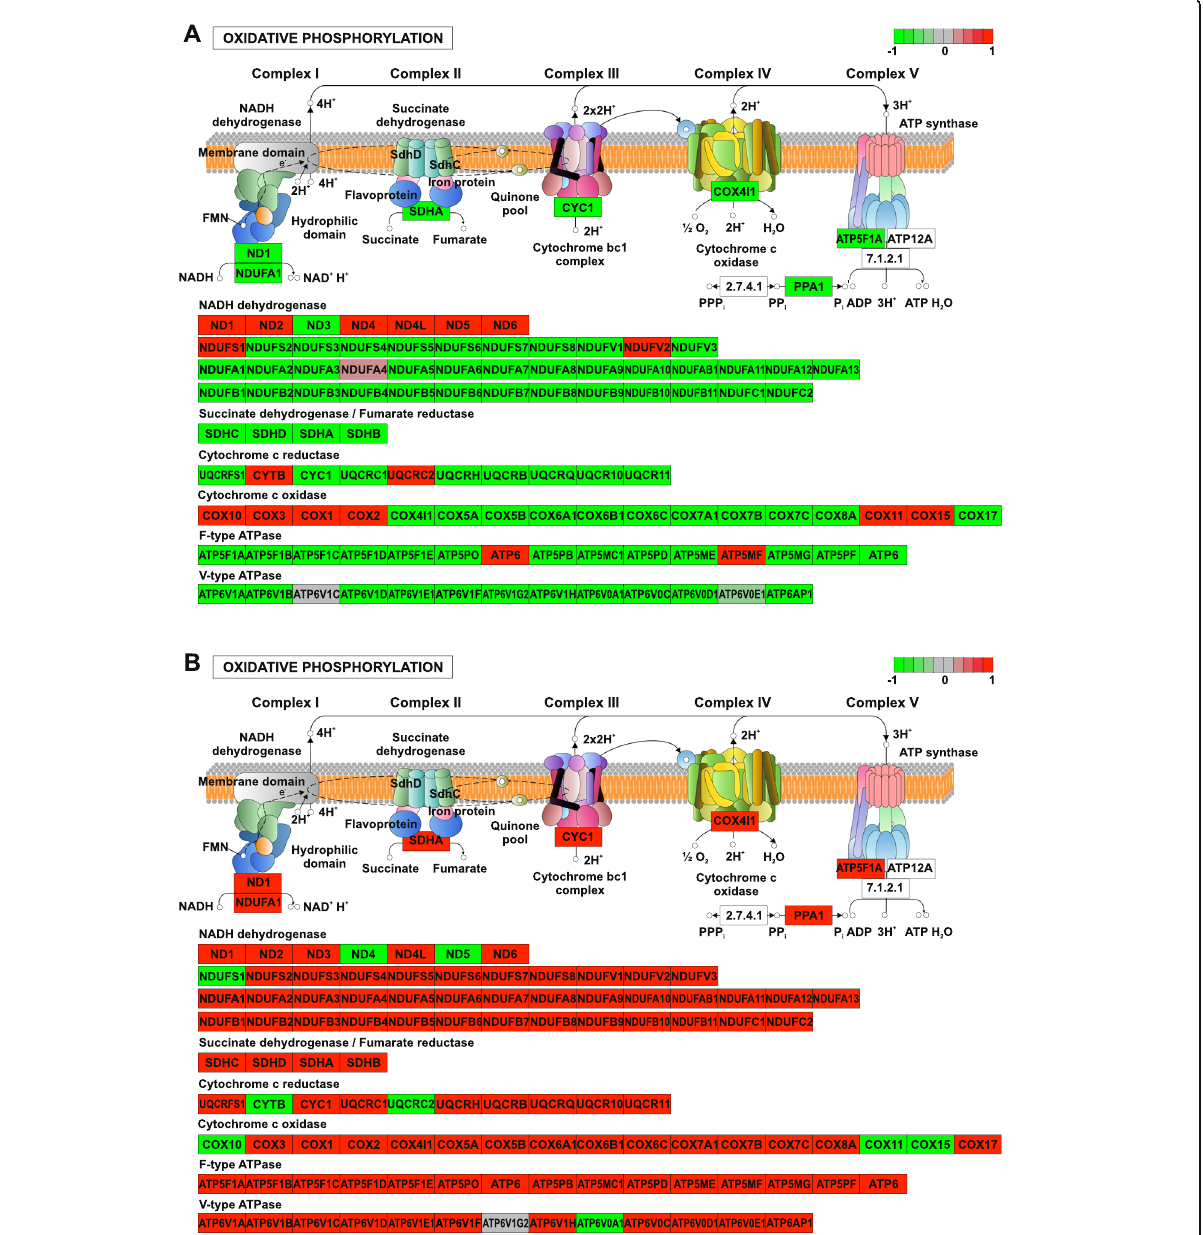
Fig. 4 Oxidative phosphorylation was implicated as a significantly altered metabolic pathway based on the ranked list enrichment analysis of all genes whose transcripts were detected from PBMC samples. Results of the analysis between ictal vs. interictal (upper panel) and interictal vs. healthy (lower panel) samples are shown. All detected genes are mapped to the pathway map. Original figure was rendered by